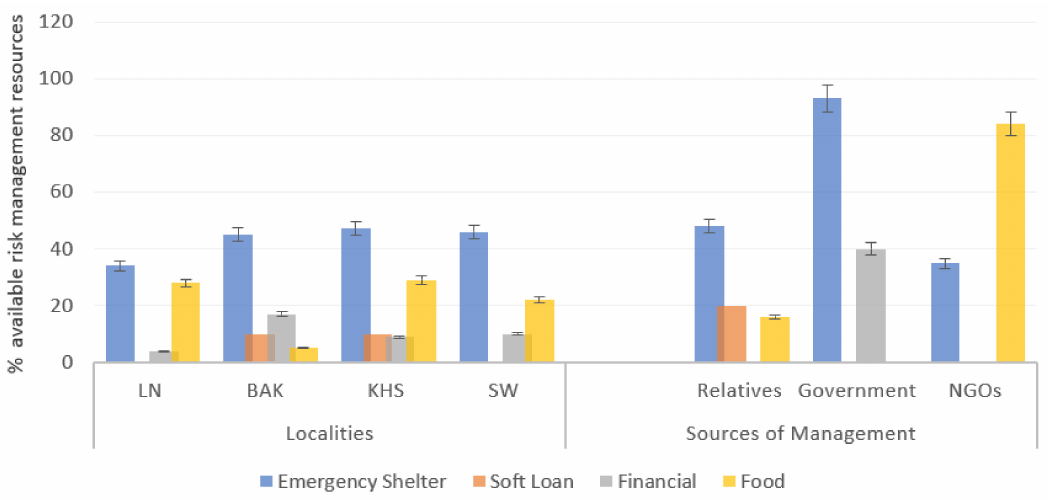
Figure 5. Flood risk management in district